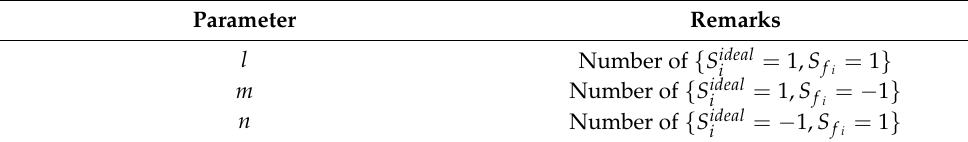
Table 4. Parameters involved in the similarity index.